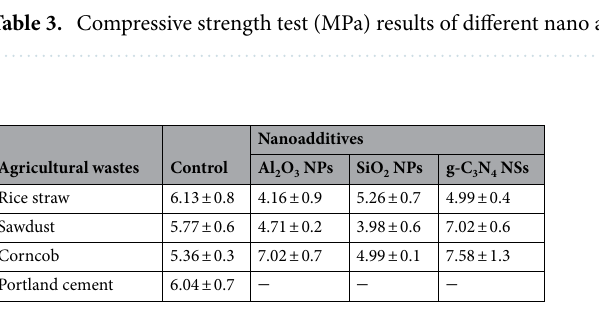
Table 4. Results of the Flexural Strength Test (MPa) of different nano additives to agricultural waste’ bio- cement.